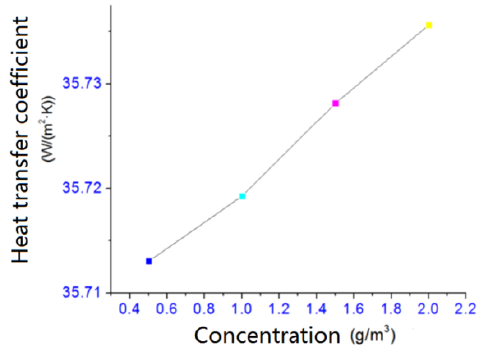
Fig. 5. Effect of coefficient on heat transfer